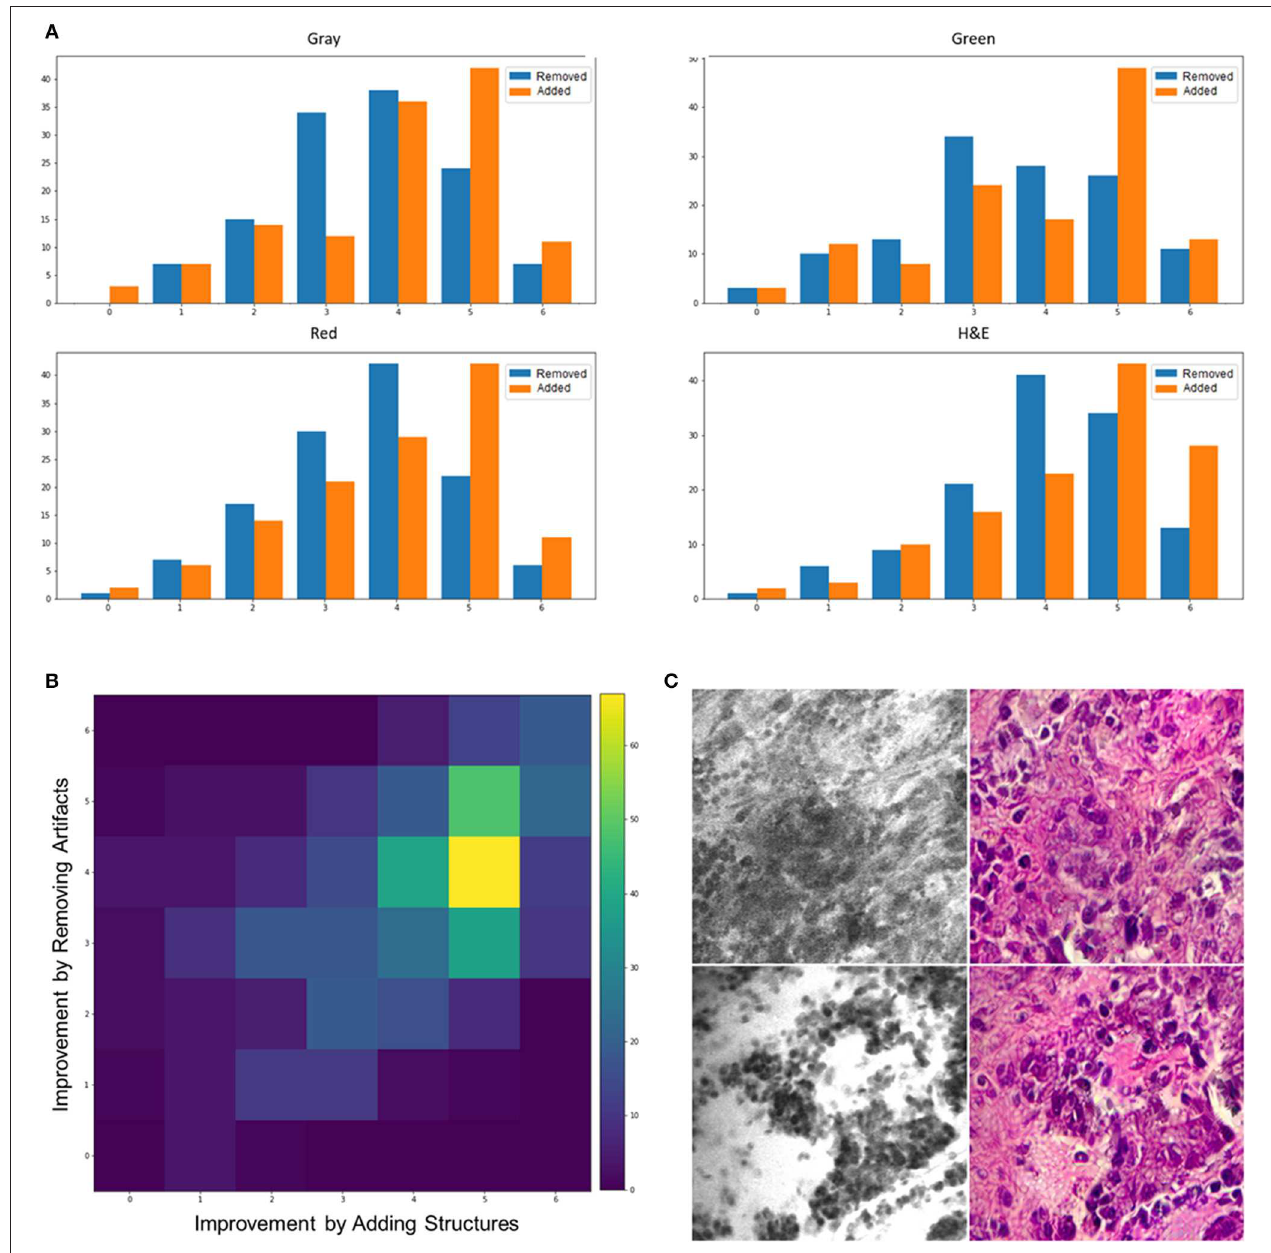
FIGURE 2 | (A) Histogram of scores for added structures and removed artifacts from different color—coded images. (B) An intensity map showing the frequency of different combinations of scores for adding structures (x axis) and removing artifacts (y axis). (C) Two example images that the stylization process removed some critical details (top) or added unreal structures